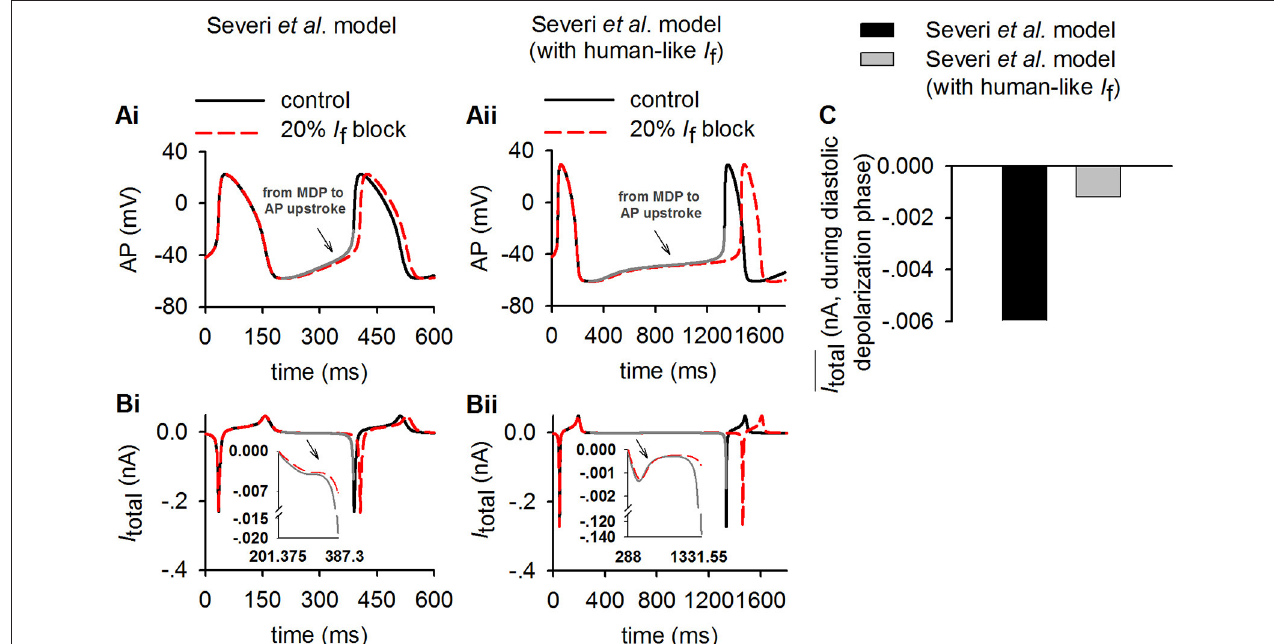
FIGURE 7 | Simulation of the inverse relationship of I total and the increasing of CL in control (solid lines) and 20% I f reduction (dotted lines) to validate theoretical analysis result (Equation 2) in method section ( p = 0.2, modeling 20% I f reduction). (Ai,Aii) Time course of action potentials for rabbit-like and human-like SAN cell models respectively (gray lines represents diastolic depolarization voltage changes from the MDP to the voltage at the beginning of AP upstroke in control condition); (Bi,Bii) time courses of I total (gray lines represents diastolic depolarization voltage changes from the MDP to the voltage at the beginning of AP upstroke in control condition). (C) Averaged value of I total amplitude during the diastolic depolarization phase for the rabbit-like (black) and human-like (gray) SAN cell models. In each case, the integral interval was set to the time interval between the MDP and beginning of the upstroke membrane potential (V up